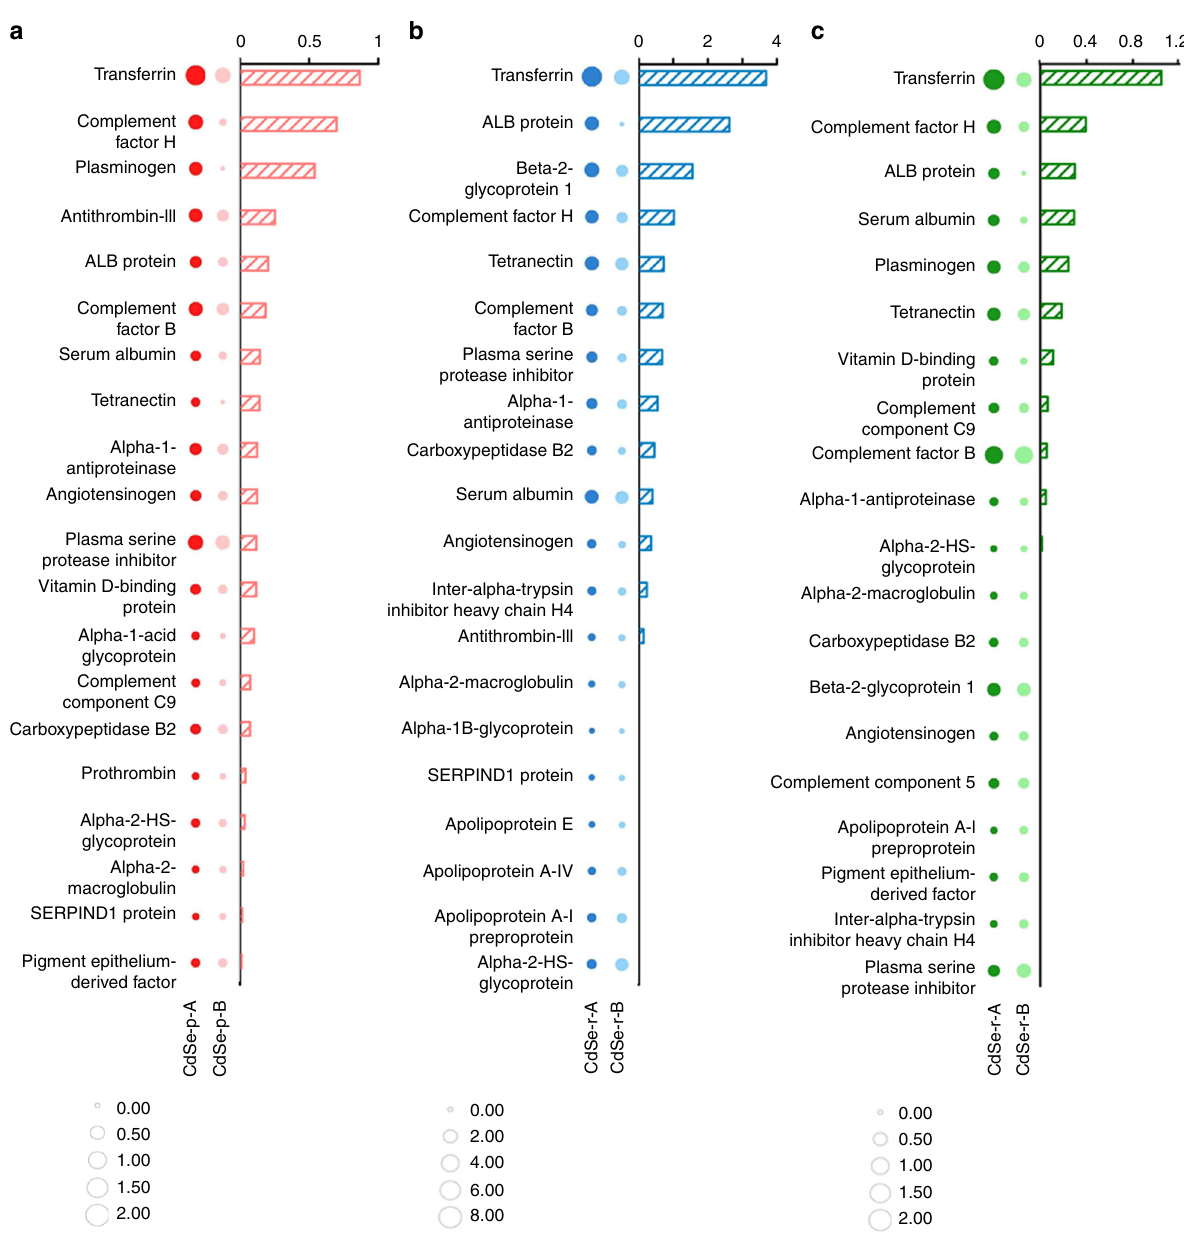
Fig. 2 Transferrin was enriched in the hard protein corona and the extent of enrichment was susceptible to the exposed facets of CdSe and CdS nanocrystals. The protein coronas were formed in fetal bovine serum. The size of the circles represented the enrichment factor of proteins in the hard corona, and the difference in the protein enrichment factors between the two different-faceted materials is shown in the bar graph. The proteins were ranked according to the decreasing difference in the enrichment factor of proteins detected from the hard coronas on the two different-faceted CdSe nanoparticles ( a , CdSe-p-A: dark red bubble; CdSe-p-B: light red bubble), CdSe nanorods ( b , CdSe-r-A: dark blue bubble; CdSe-r-B: light blue bubble), and CdS nanorods ( c , CdS-r-A: dark green bubble; CdS-r-B: light green bubble). Source data are provided as a Source Data fi